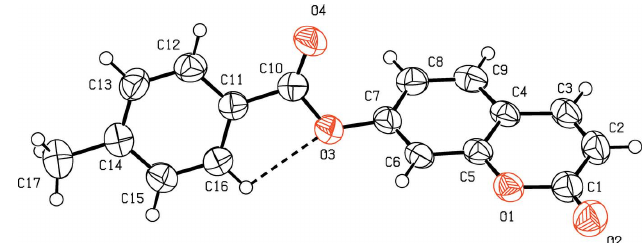
Table 1 Hydrogen-bond geometry (A˚ , (cid:2)